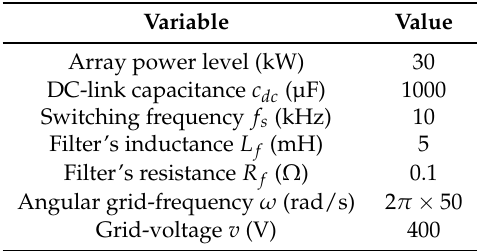
Table 1. Parameters of the grid-connected PV system.